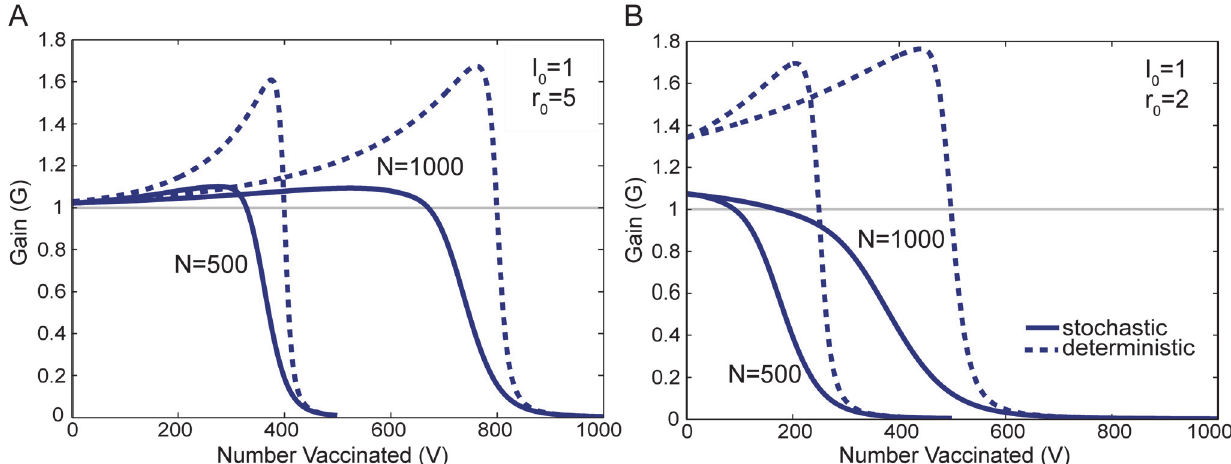
Fig 3. Gain G as a function of the vaccine allocation V . For both the stochastic (solid lines) and deterministic (dashed lines) models, Figs. 3A and 3B illustrate G (i.e. slopes) of the I 0 = 1 curves in Figs. 2A and 2B, respectively. Figure A shows G for r 0 = 5 for both a population of N = 500 individuals and also one of N = 1000 individuals. Figure B shows the corresponding results for r 0 = 2. The gain curves for a population of N = 500 terminate at V = 500 and those for a population of N = 1000 terminate at V =